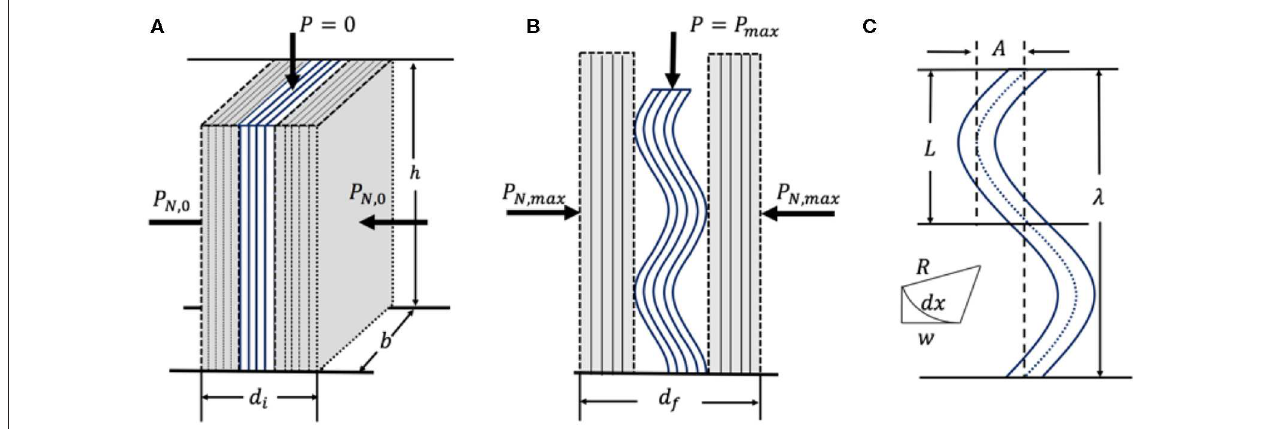
FIGURE 4 | (A) Initial configuration where layers are confined by force P N,0 . (B) Configuration at maximum indentation, h 2.5 , showing vertically loaded four-layer ripple that buckled into 4 modes. (C) Definitions of w , wavelength, λ = 2L and amplitude, A RB